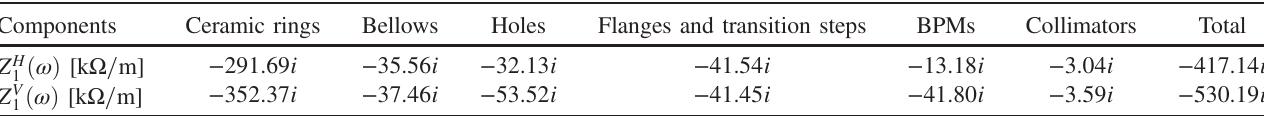
TABLE I. Transverse broadband impedances for the components of